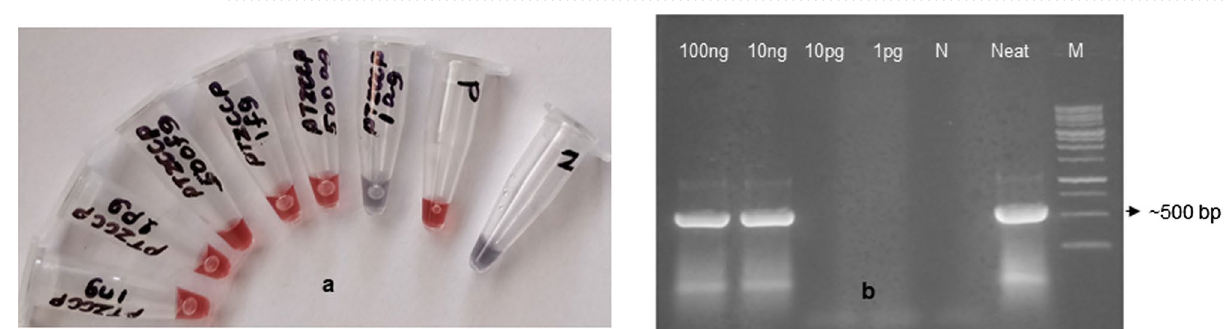
Figure 9. Comparison of the sensitivity of the AuNP assay and PCR (M13 primers) using different concentrations of plasmid (pTZCCPp3) diluted with Milli Q water. ( a ) AuNP assay with clccpi1 thiol probe was able to detect plasmid up to 500 ag/µl. ( b ) PCR was able to detect plasmid up to 10